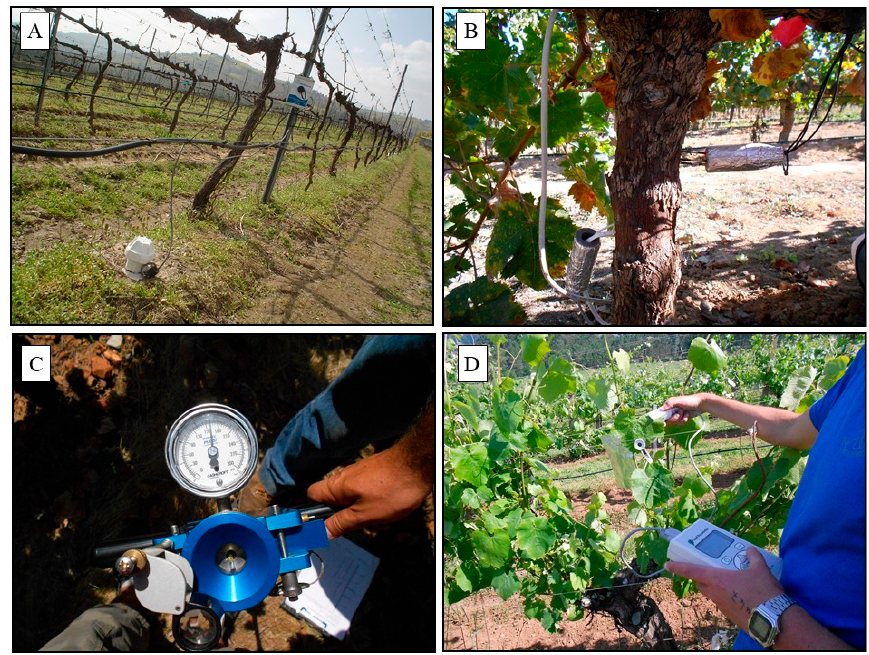
Figure 3. Devices for the assessment of grapevine water status: ( A ) Soil capacitance probe for continuous monitoring of soil water content; ( B ) Sap flow probe in the trunk of a grapevine; ( C ) Pressure chamber; ( D ) Hand-held porometer for determining stomatal conductance. Photos were taken by J.M. Mirás-Avalos.